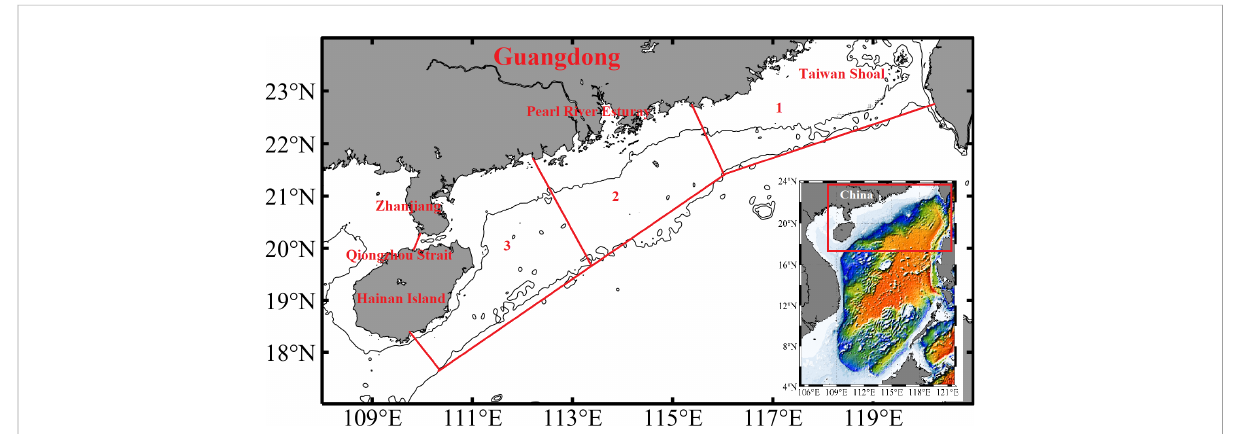
FIGURE 1 Bathymetry of the northern South China Sea (NSCS). Black contours indicate 50-m and 200-m isobaths. The study region is subdivided into three shelf zones (red lines) for subsequent